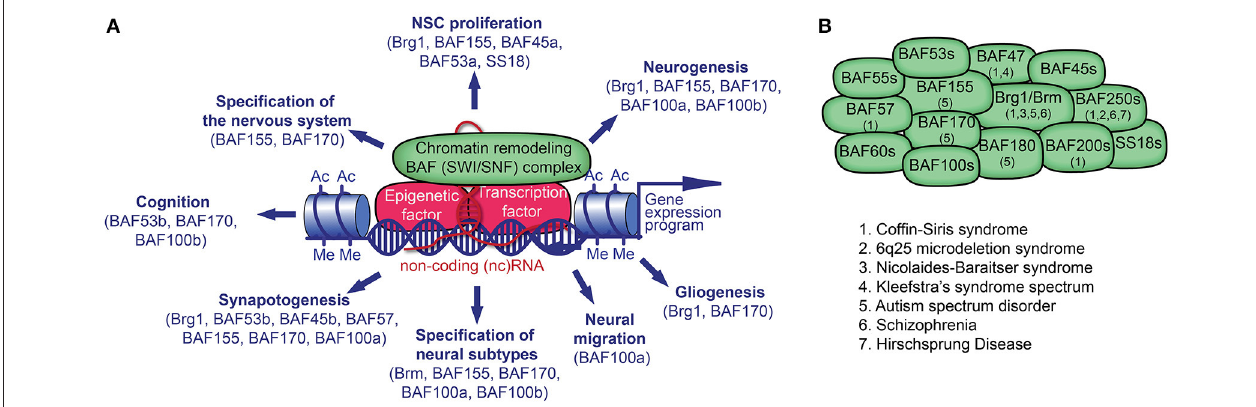
FIGURE 1 | Chromatin remodeling BAF (mSWI/SNF) complex in neural development and disorders. (A) The BAF complex, epigenetic factors (including non-coding [nc] RNA), and transcription factors (TF) control gene expression. TFs and ncRNAs bind to specific DNA sequences. The recruitment of BAF complexes and other epigenetic factors on the genome leads to altered epigenetic marks (e.g., histone acetylation, Ac; histone methylation, Me) and chromatin structure in order to activate or repress a specific gene expression program in cell lineages. Many BAF subunits as indicated, regulate distinct processes of neural development. (B) The presence of known BAF subunits in different BAF complexes in neural cells is indicated. The mutation of genes encoding for the noted BAF subunits has been reported in various neurological disorders.